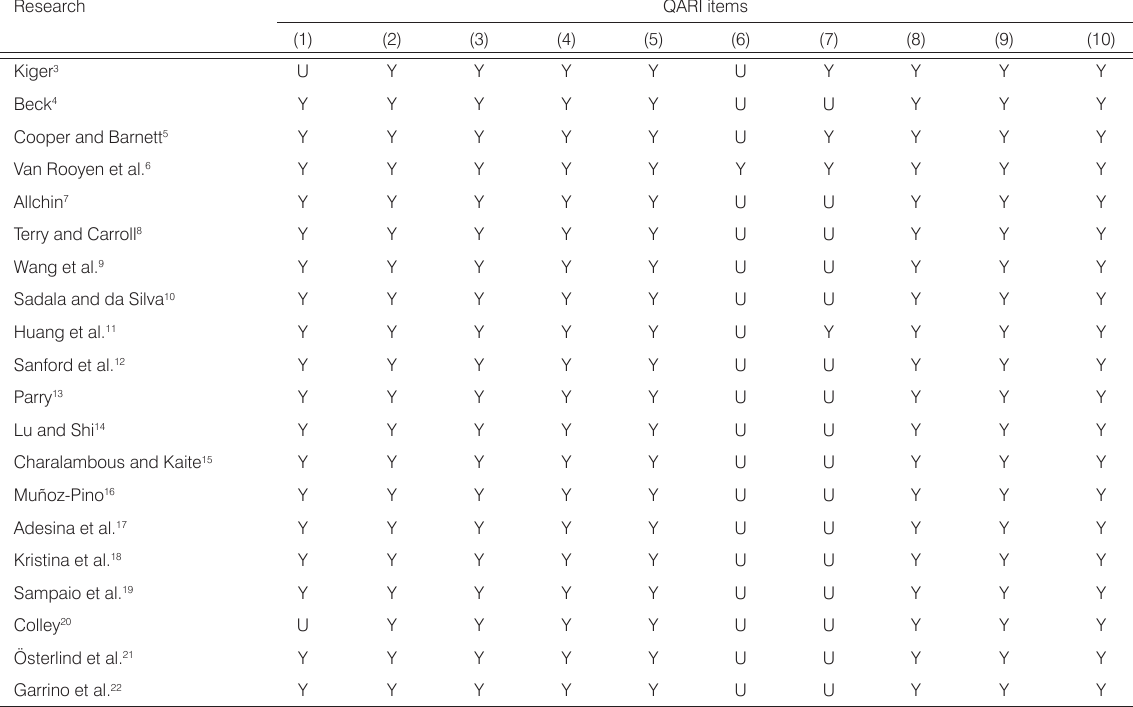
Table 1. Quality assessment of the included articles.